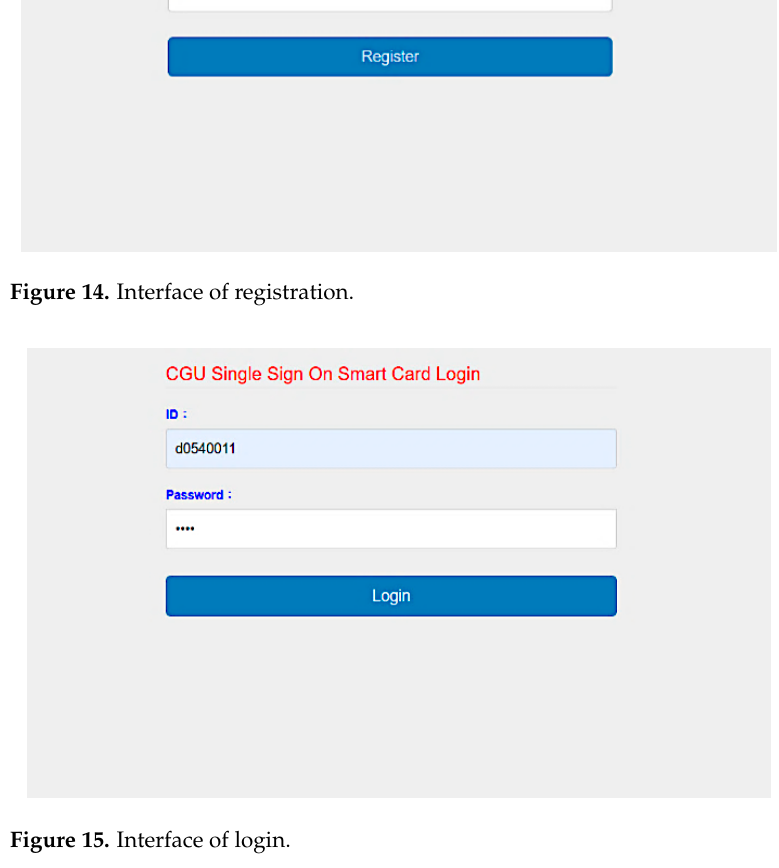
Figure 15. Interface of login.